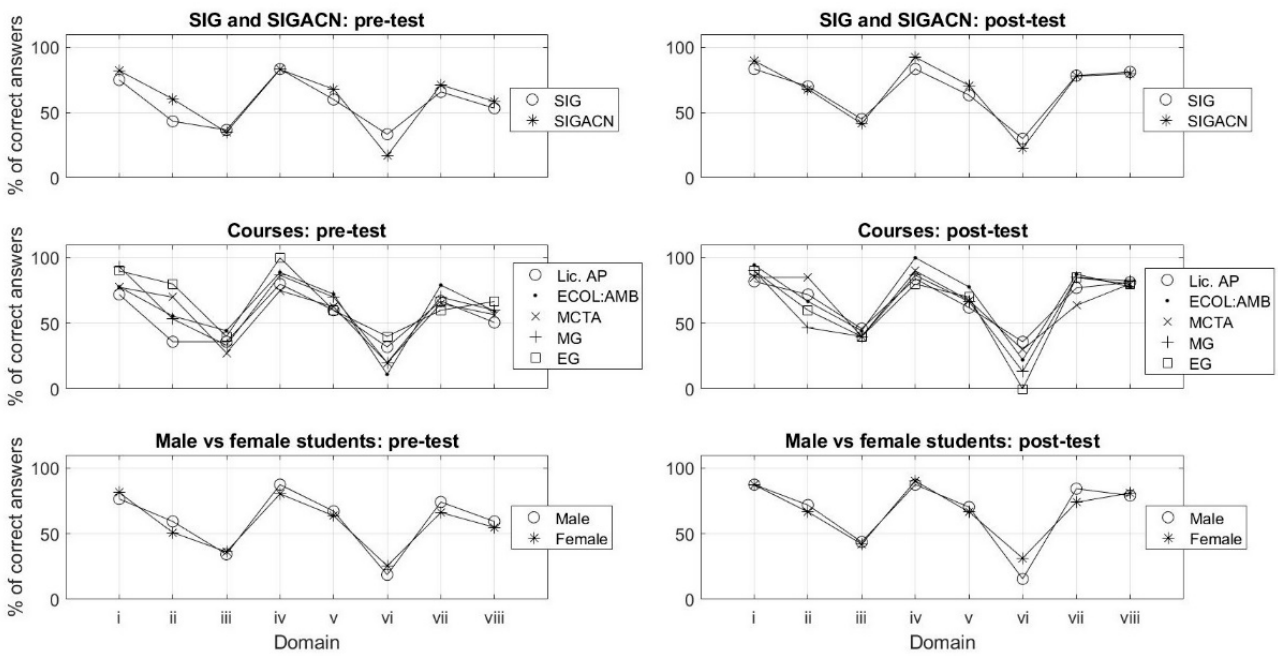
Figure 2. Percentages of students with correct answers on each STAT question, by curricular units ( first row ) and courses ( second row ), in the pre- ( left plots ) and post-test ( right plots ) moments. The average (standard deviation) of the STAT total score significantly increased from 9.7 (1.9) in the pre-test to 11.3 (2.0) in the post-test ( p < 0.001, Figure 3), suggesting